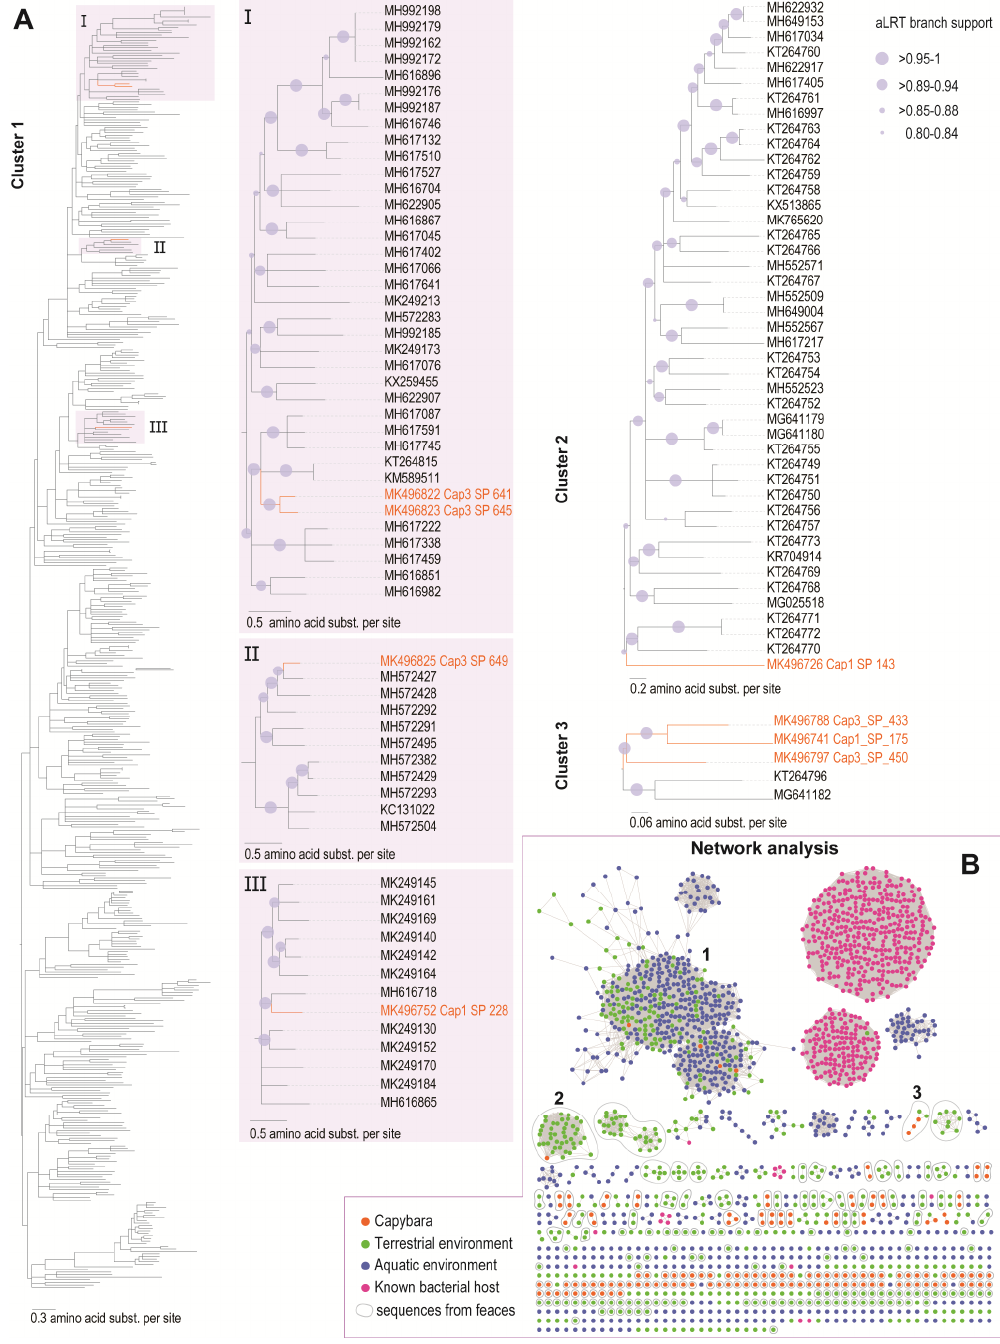
Figure 5. ( A ). Maximum Likelihood phylogenetic trees of the three main clusters ( ≥ 5 sequences) containing the capybara associated microviruses. The ML phylogenetic tree of cluster 1 has the branches in purple expanded (I, II, III). ( B ). Sequence similarity network of the major capsid protein (MCP) amino acid sequences of the capybara associated microviruses with a representative dataset of microviruses (MCP_all). Sequences are color-coded based on the type of environment they were recovered (terrestrial in green, aquatic in blue, and from known bacterial hosts in pink). The capybara samples are represented by orange dots, and all sequences derived from faeces are circled in grey.